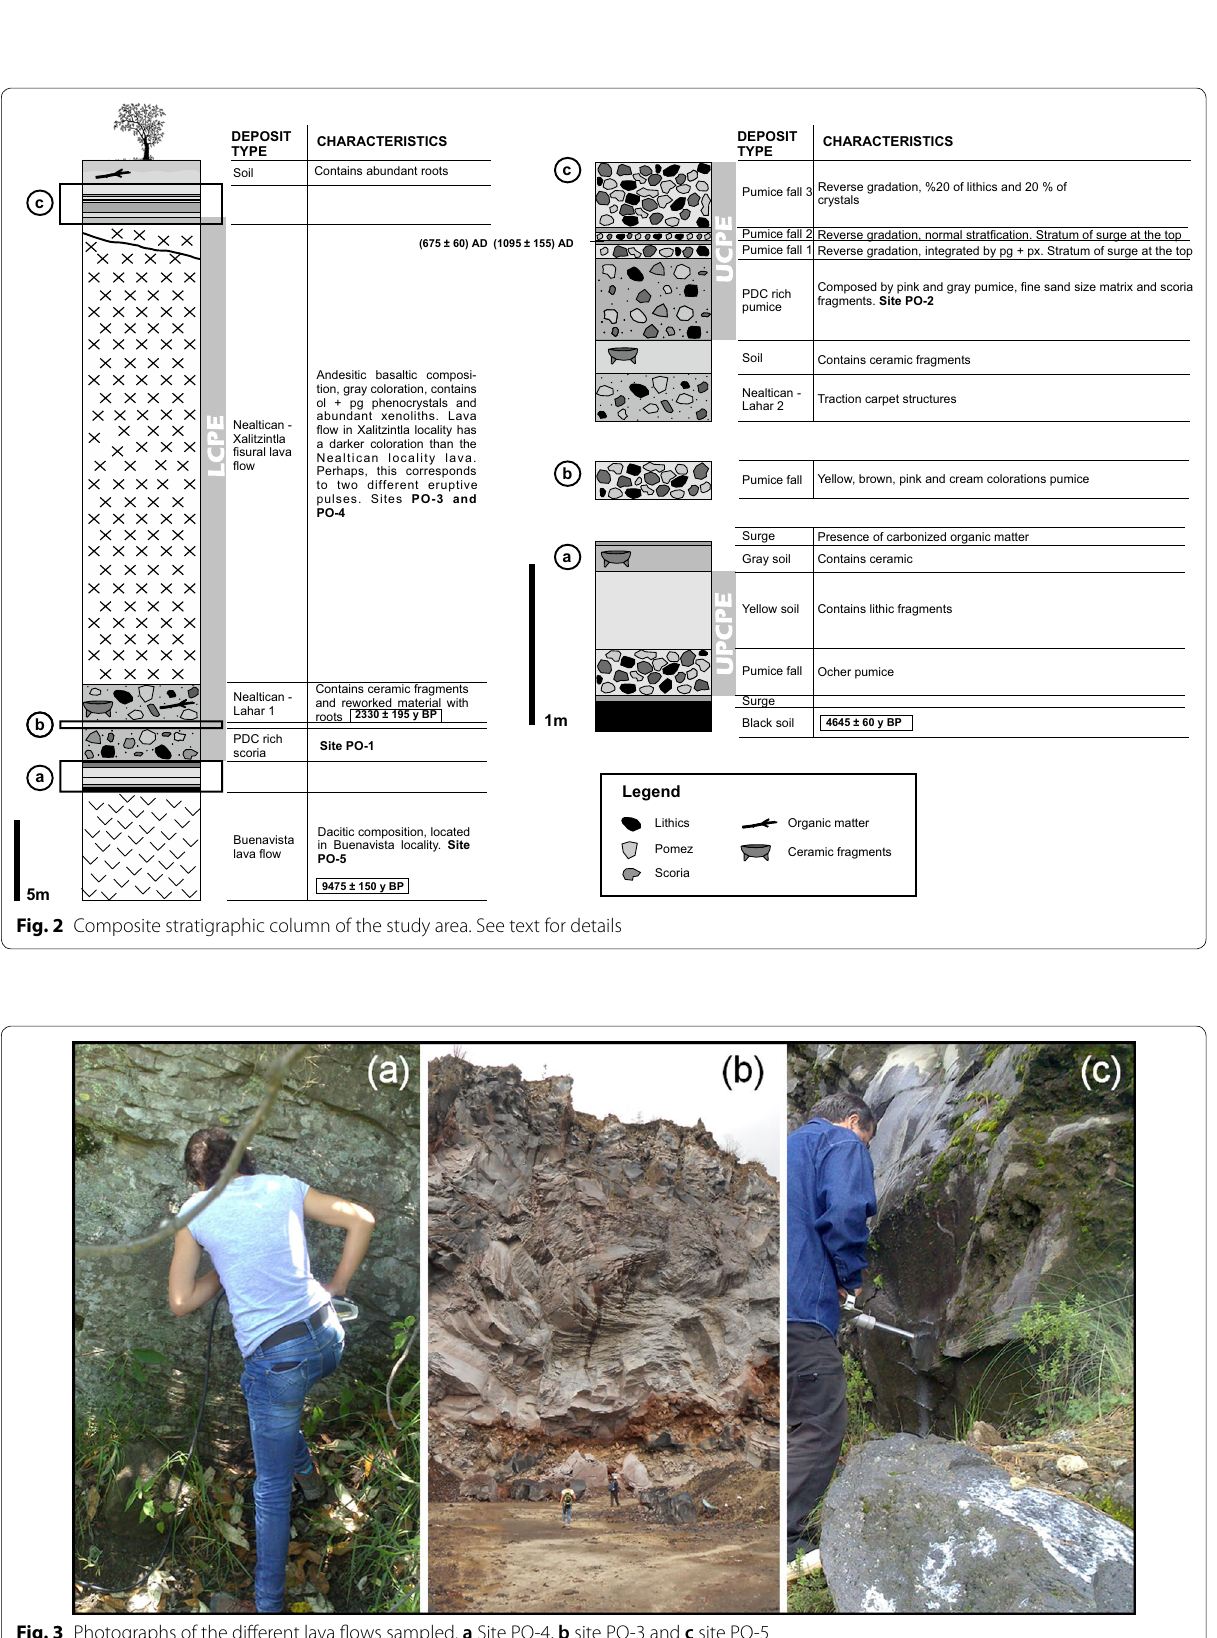
Fig. 3 Photographs of the different lava flows sampled. a Site PO‑4, b site PO‑3 and c site